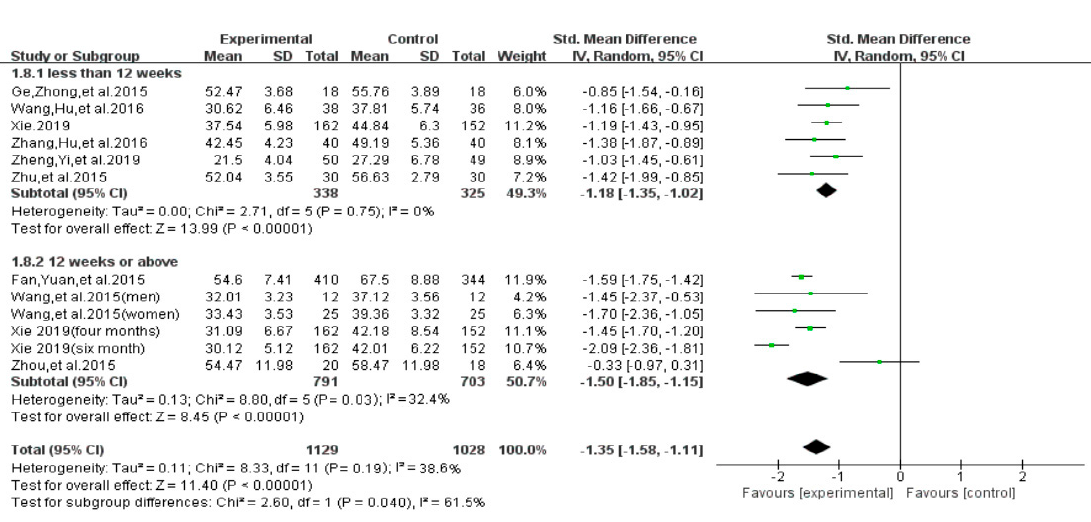
Figure 12. Effects of exercises on level of smartphone addiction.